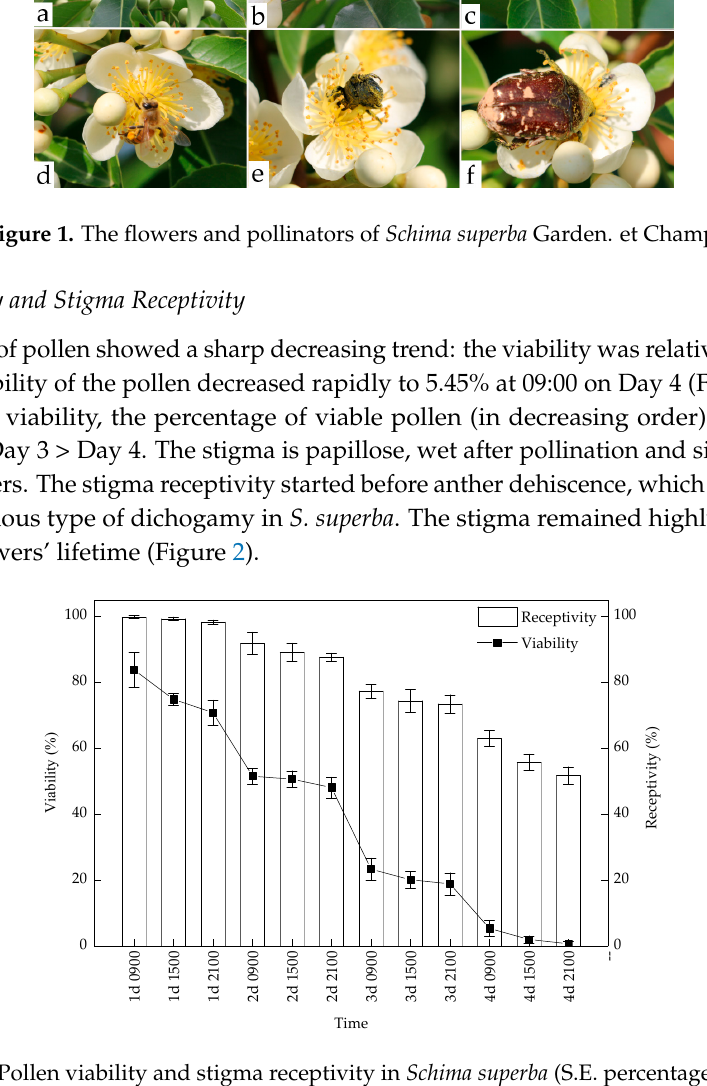
Table 1. Floral characteristics of Schima superba Garden. et Champ (S.E.).